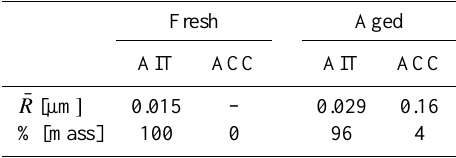
Table 1. Specifications of the two size distributions used for ship emission fluxes obtained from Righi et al. (2011). The ship emis- sions are treated as lognormal size distributions and are partitioned into the soluble Aitken (AIT) and accumulation (ACC) modes based on the mass percentage at the mean radius ¯ R